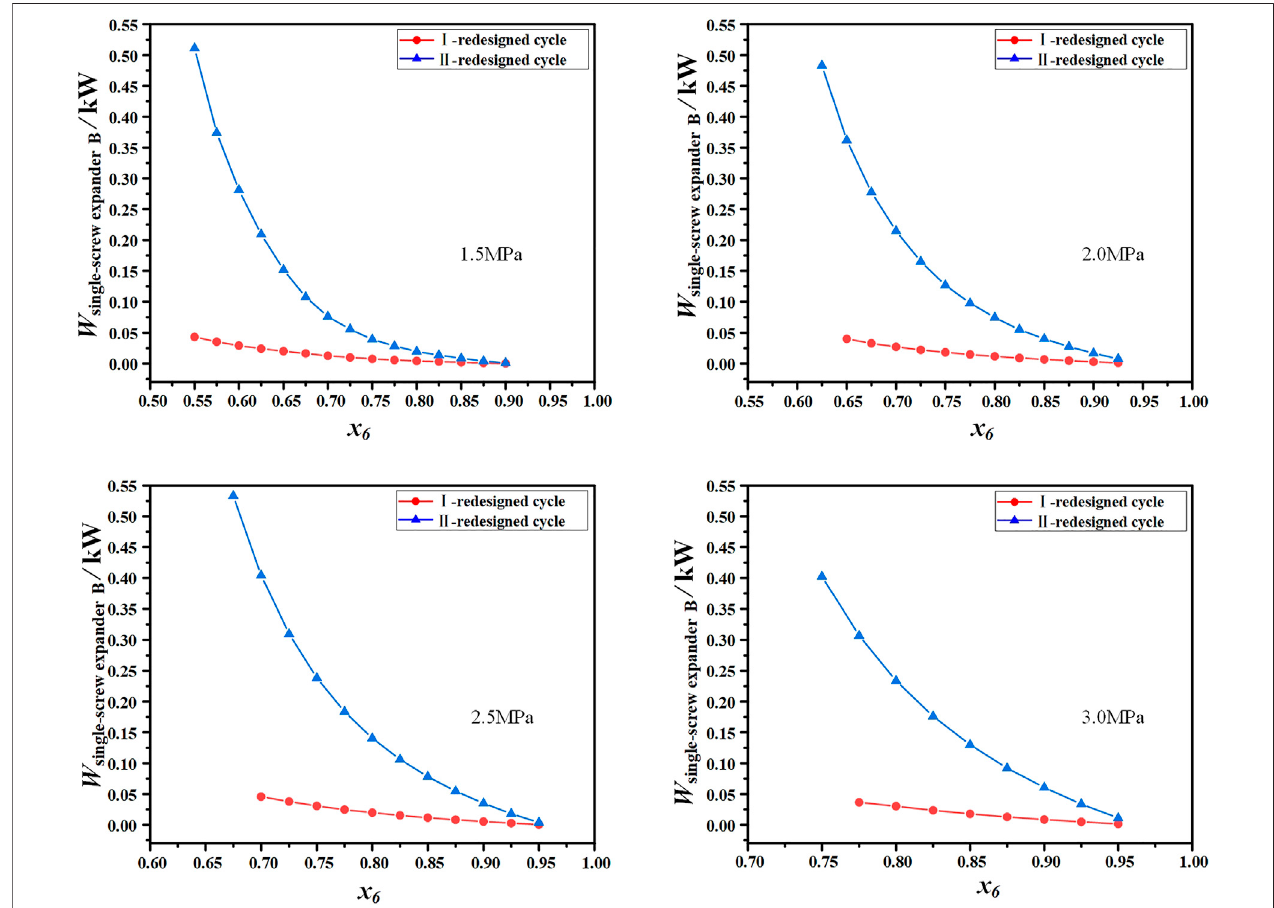
FIGURE 9 | The variation of the work produced by SSE B with the evaporation pressure and ammonia-water concentration in the I- and II-redesigned cycles.